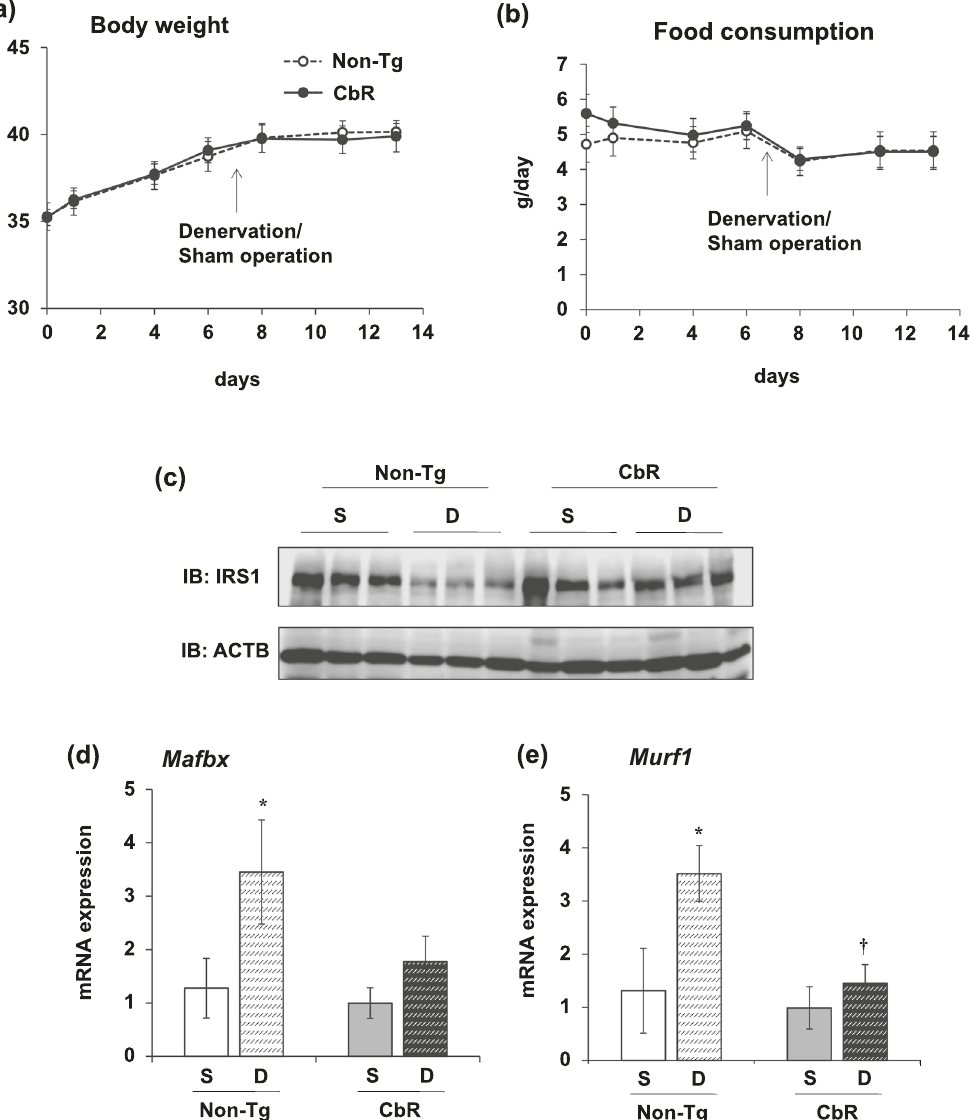
Fig. 5 Effects of diets supplemented with Cblin-enriched or non-transgenic rice on sciatic denervated or sham-operated gastrocnemius muscles of mice. Body weight ( a ) and food consumption ( b ) during experimental period in mice fed with diets containing non-transgenic (non-Tg; un fi lled circles) or Cblin-supplemented (CbR; fi lled circles) rice. Results are shown as means ± SEM ( n = 5 – 6 per group). Expression of IRS1 protein ( c ) and Mafbx ( d ) and Murf1 ( e ) genes associated with muscle atrophy in sciatic denervated or sham-operated gastrocnemius muscles of mice fed with diets containing non-Tg or CbR. Results are shown as means ± SEM ( n = 5 − 6 per group). * P < 0.05 (S vs. D). † P < 0.01 (non-Tg vs. CbR). D, denervated; S,